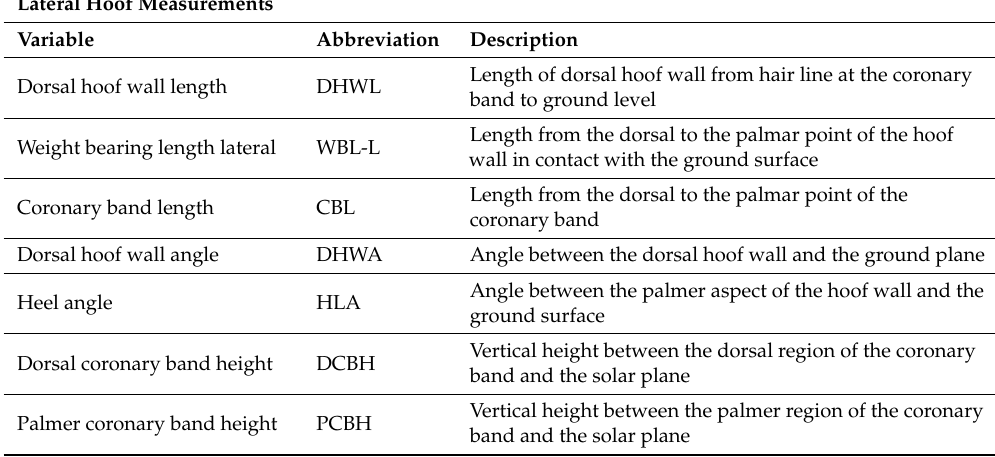
Table 2. Angular and linear morphometric variables measured from the 2D lateral view images of the hoof [22,23].